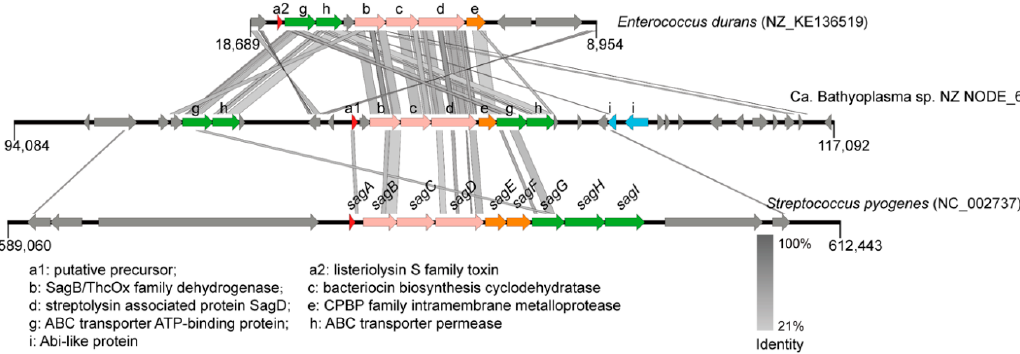
Figure 5. The linear azol(in)e-containing peptide synthesis gene cluster in Ca. Bathyoplasma sp. NZ. tBLASTx searches were performed against the listeriolysin S synthesis gene cluster in Enterococcus durans and the streptolysin O synthesis gene cluster in Streptococcus pyogenes with an e-value of 1e-5. Homologous regions are indicated with gray frames. The loci for the putative bacteriocin precursor, core enzymes, ABC transporter-related proteins, membrane-associated proteins, and other related proteins are shown in red, pink, green, orange, and blue, respectively. SagA~I, streptolysin associated protein A~I.